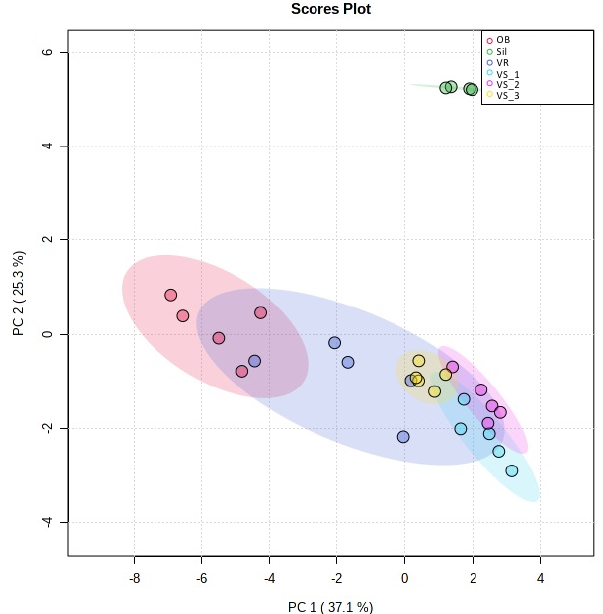
Figure 4. Principal component analysis (PCA) scores plot of the polar lipid species displaying the lowest q values, i.e., the top 25 polar lipid species with the higher discriminating power. Sub-region abbreviations: Vilar Seco_1 (VS_1), Vilar Seco_2 (VS_2), Vilar Seco_3 (VS_3), Silgueiros (Sil), Oliveira de Barreiros (OB), and Vila Ruiva (VR).